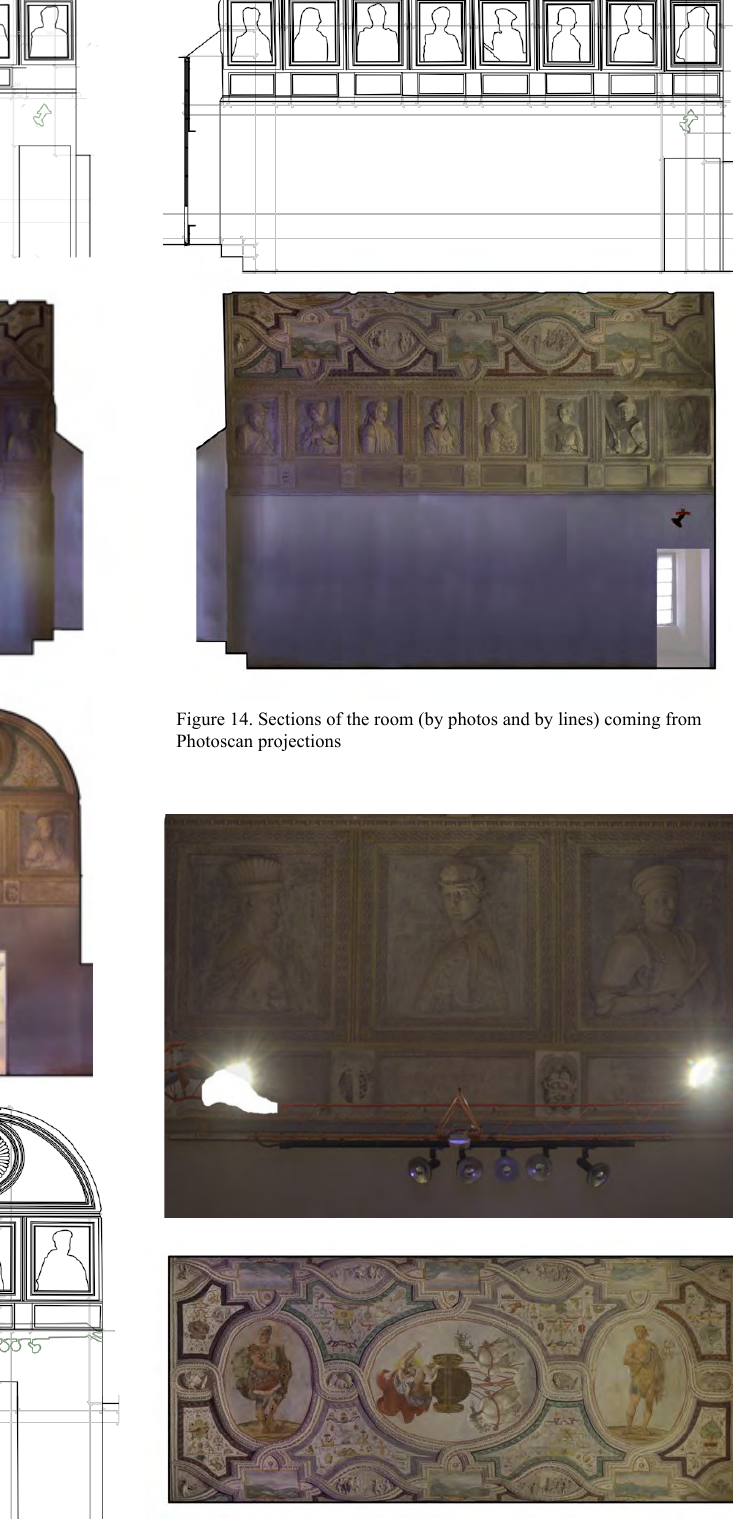
Figure 15. Details of the room and ceiling coming from Photoscan